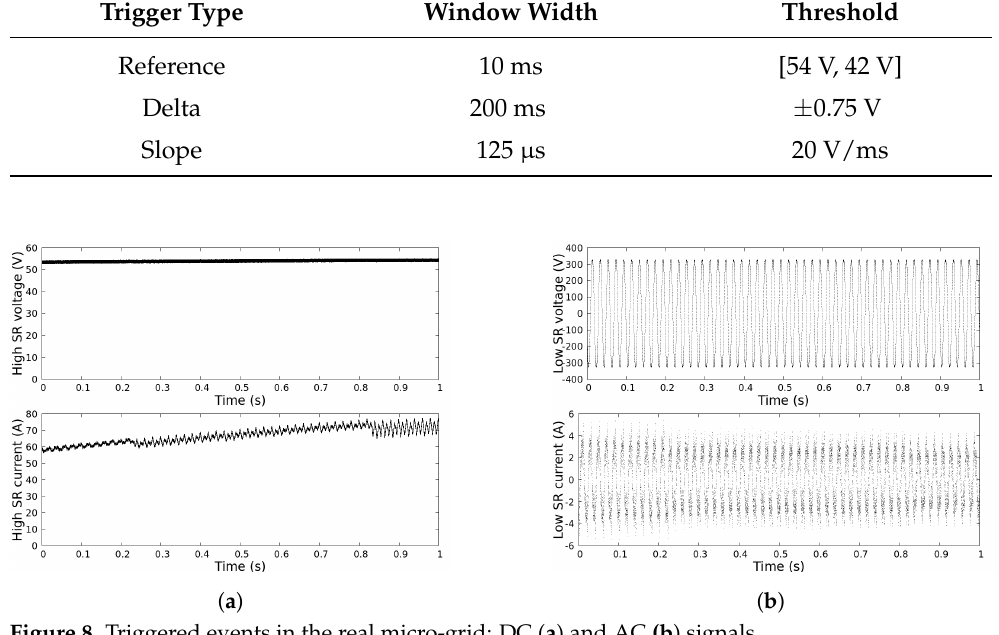
Figure 8. Triggered events in the real micro-grid: DC ( a ) and AC (b )